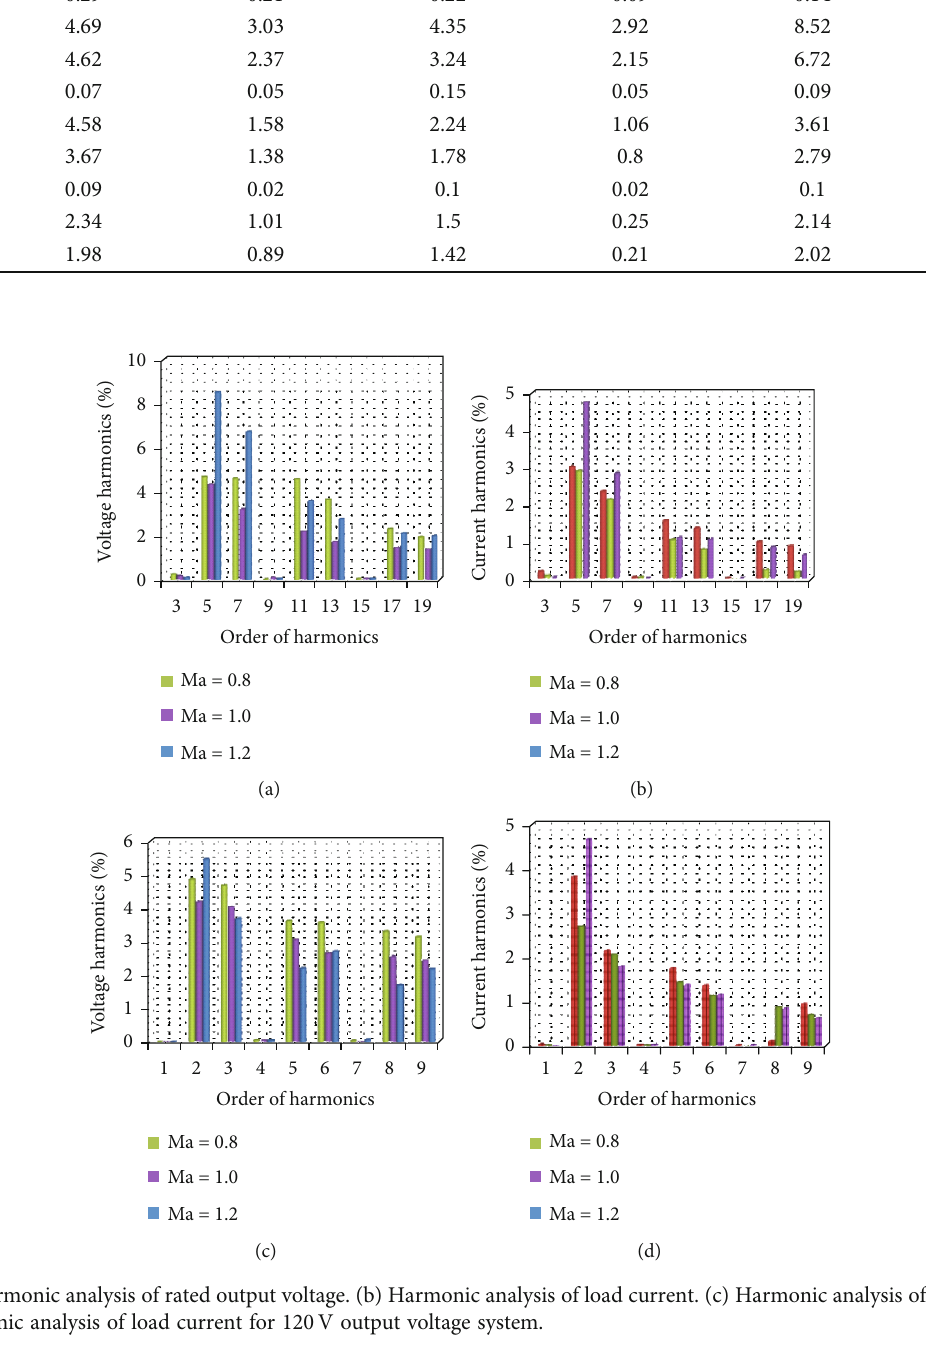
Table 4: Harmonic investigation of three-phase BMLDCLC fed RL load (rated voltage). Order of